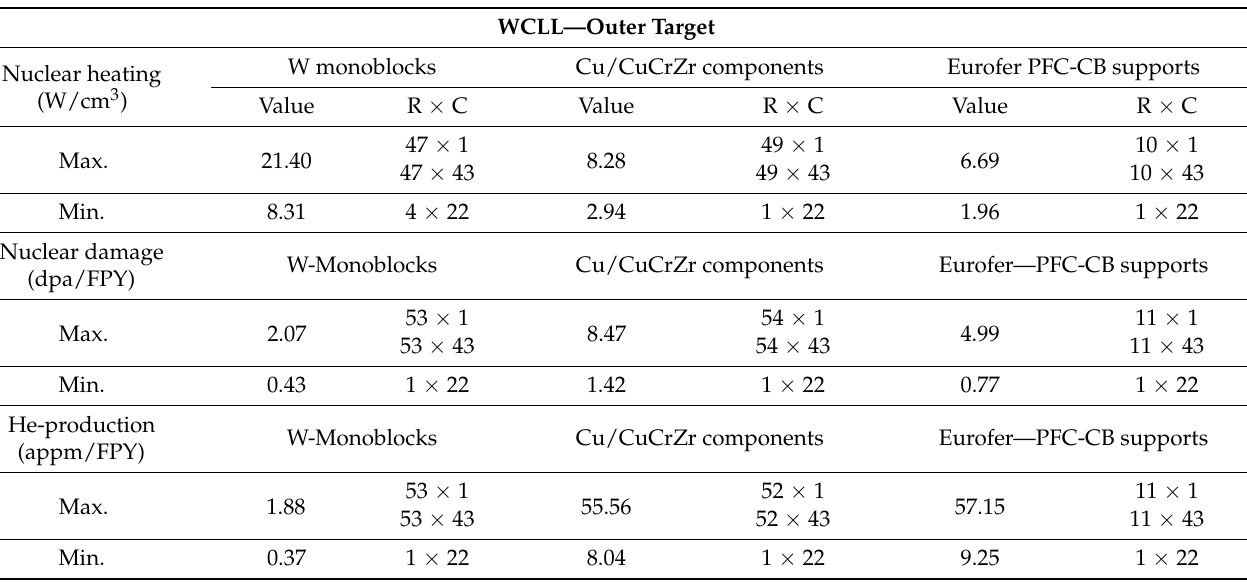
Table 7. Maximum and minimum values and related position (in terms of row (R) and column (C) of the array) of nuclear heating density (W/cm 3 ), nuclear damage (dpa/FPY), He-production (appm/FPY) on the PFCs of the WCLL outer